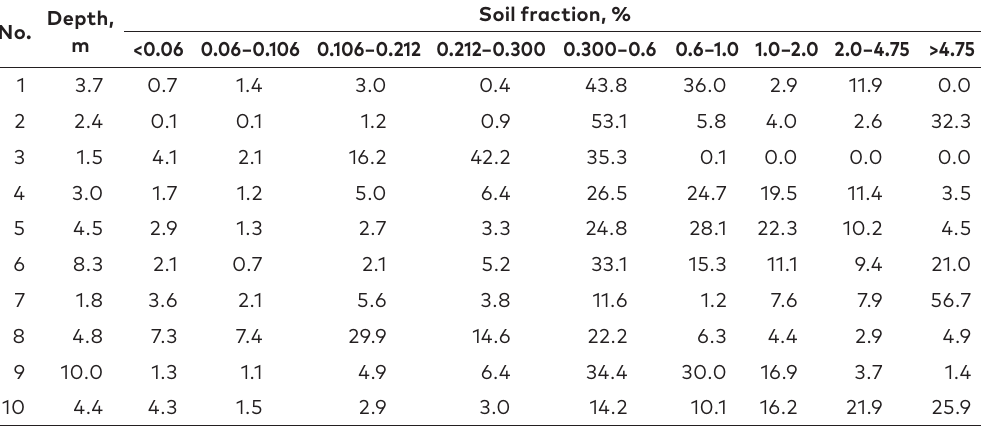
Table 4 . Results of determining the name of coarse soils based on different